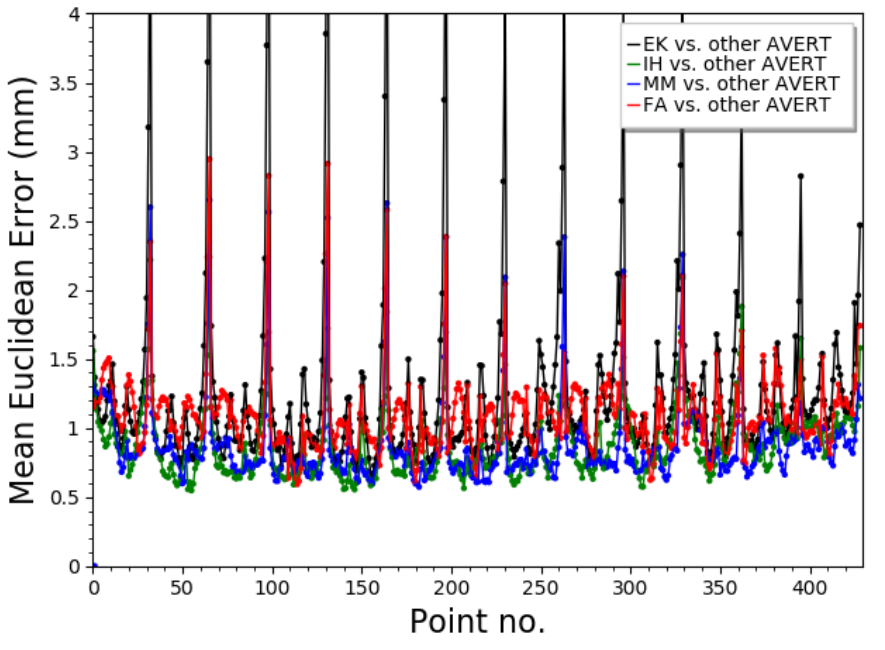
Figure 5. Mean point-wise errors for all observers. Table 1. Median errors for each observer across all points.